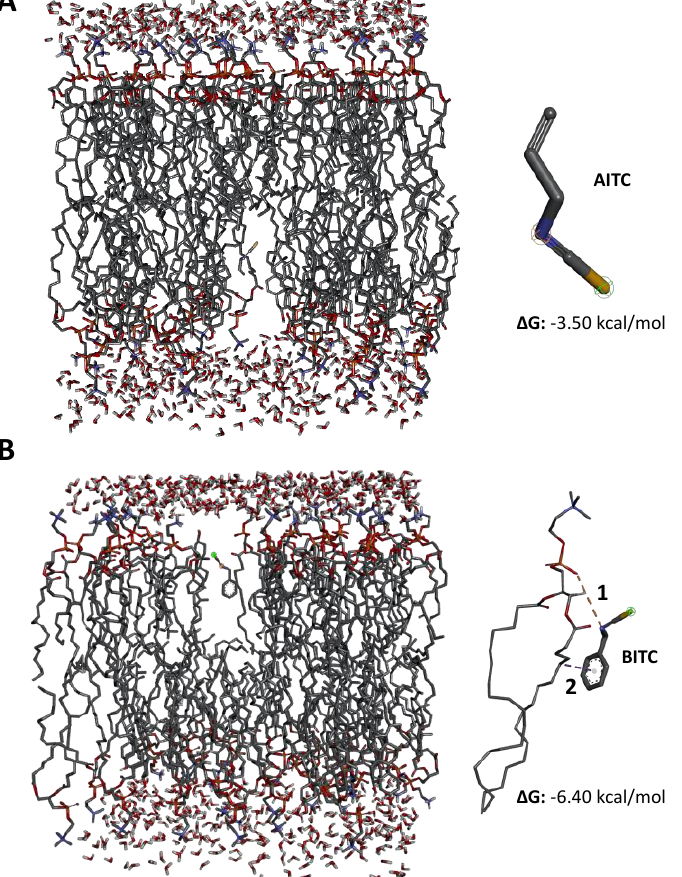
Figure 7. In silico screening of the binding affinity between a complex 1-palmitoyl-2-oleosyl-sn-glycero-3-phosphocholine (POPC), 1-palmitoyl-2-oleosyl-sn-glycero-3-phosphoetanoamine, and cholesterol membrane and ( A ) allyl isothiocyanate (AITC) and ( B ) benzyl-isothiocyanate (BITC). ∆ G: Gibbs free energy; 1: attractive charge; 2: Pi-alkyl.